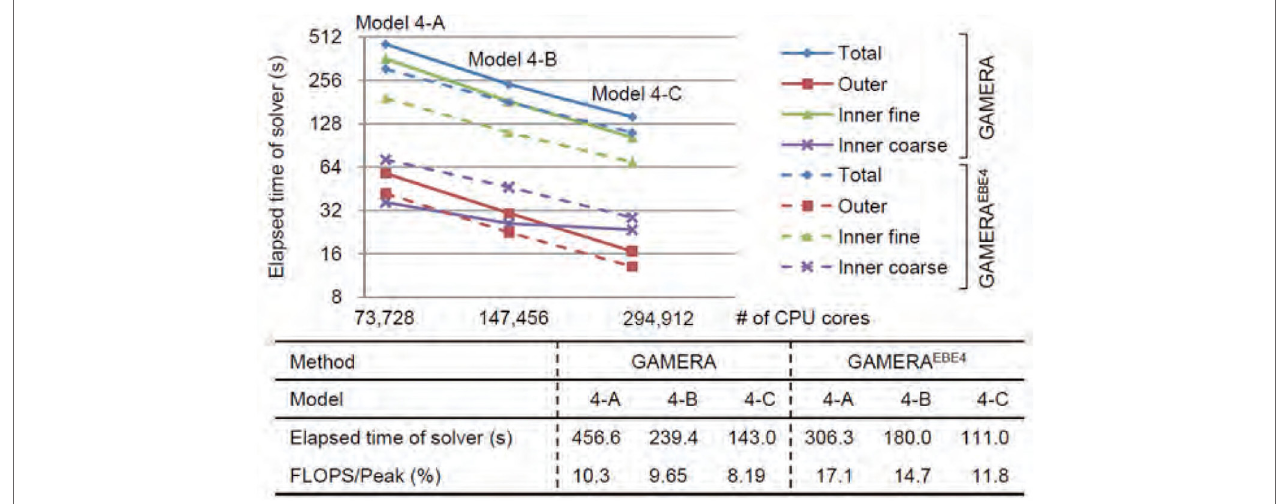
FigUre 3 | Scalability of developed FEM: GAMERA and GAMERA EBE designate the usage of the element-by-element method (GAMERA does not use it); Model 4-A, 4-B, and 4-C have different DOF; outer, inner fine, and inner coarse provide the breakdown of the developed multi-grid solver processes, with outer for the finest grid with double precision arithmetic’s, inner fine and coarse for the coarse grid with single and double precision arithmetic’s,